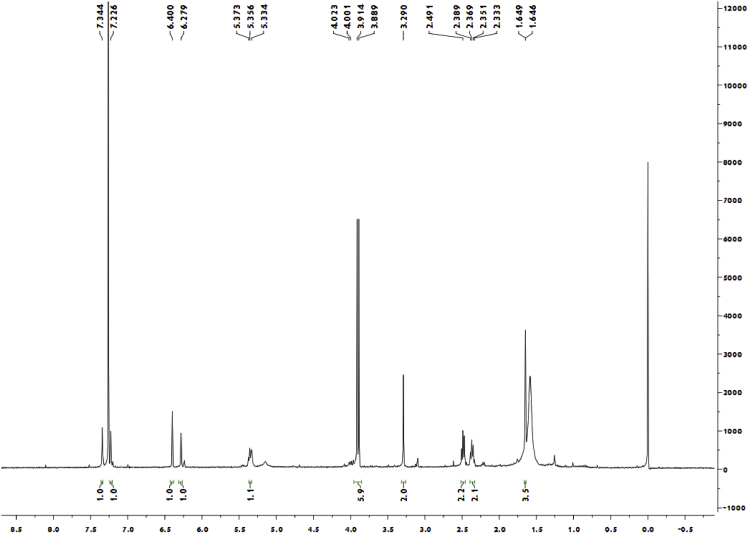
1H-NMR spectrum of meroterpenoid 9.